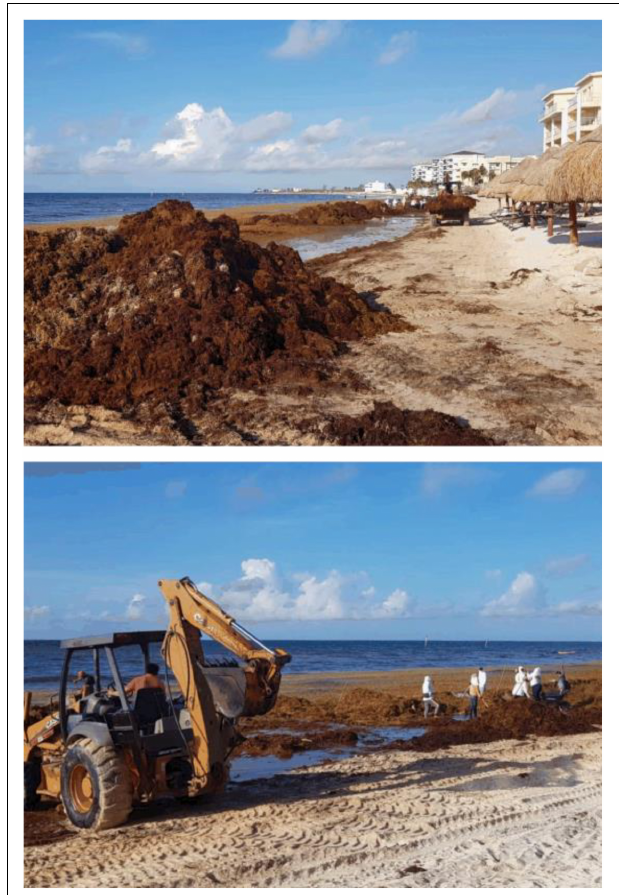
FIGURE 3 | Sargasso collection at Puerto Morelos (20 ◦ 49.7 (cid:48) N 86 ◦ 53.6 (cid:48) W, see Figure 2A ), June